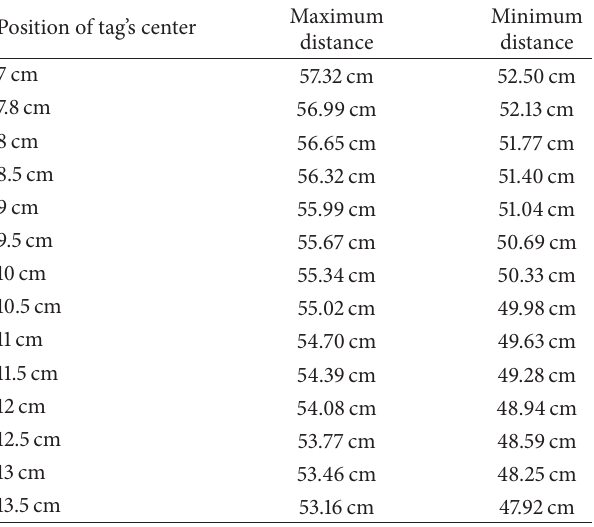
Table 7: Distance between the antenna and the center of the RFID